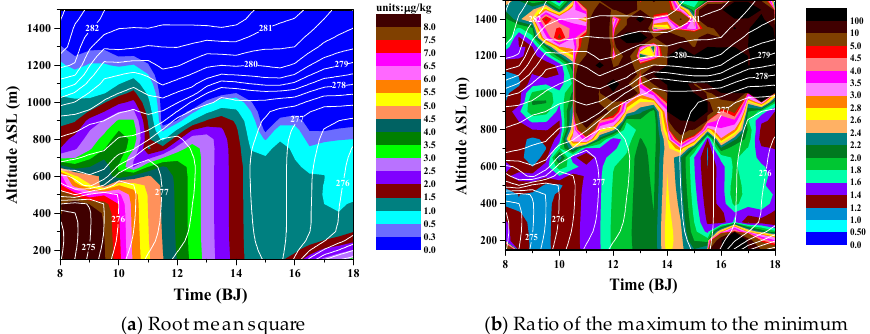
Figure 12. Simulation results of the root mean square (shading, unit: µ g / kg) and the ratio of the maximum to the minimum (shading) BC concentration at the six grid points. The white contours represent the potential temperature (unit: K). ( a ) Root mean square; ( b ) Ratio of the maximum to the minimum